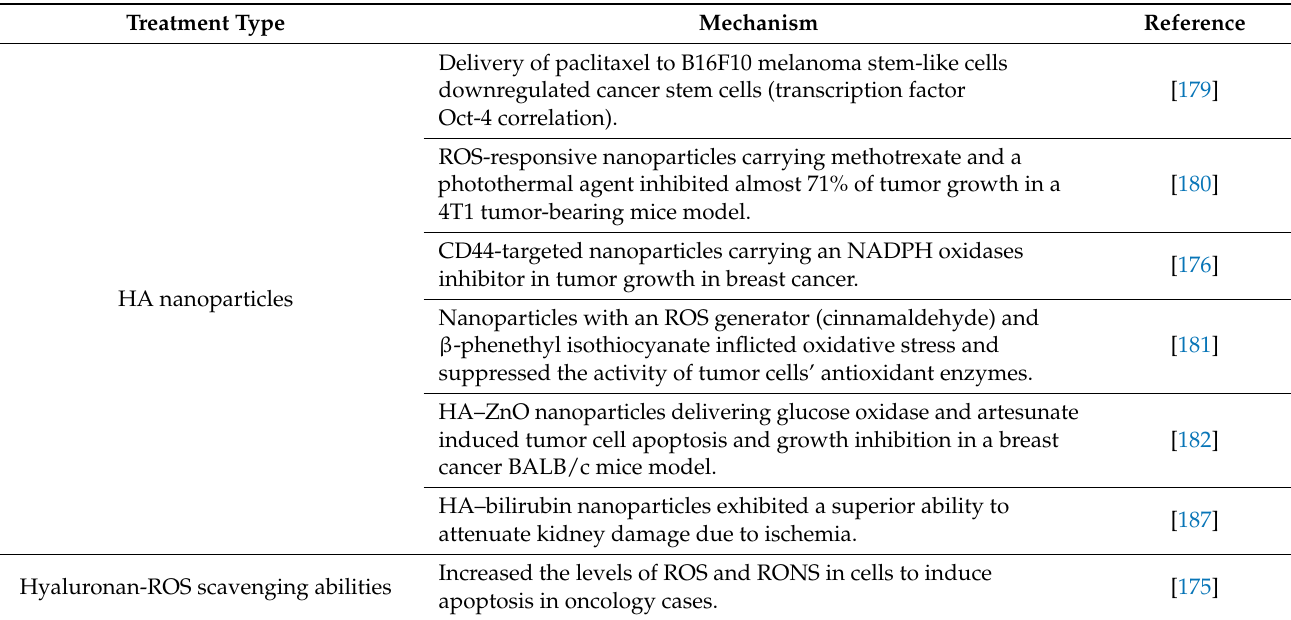
Table 3. Use of HA in ROS-dependent therapeutical